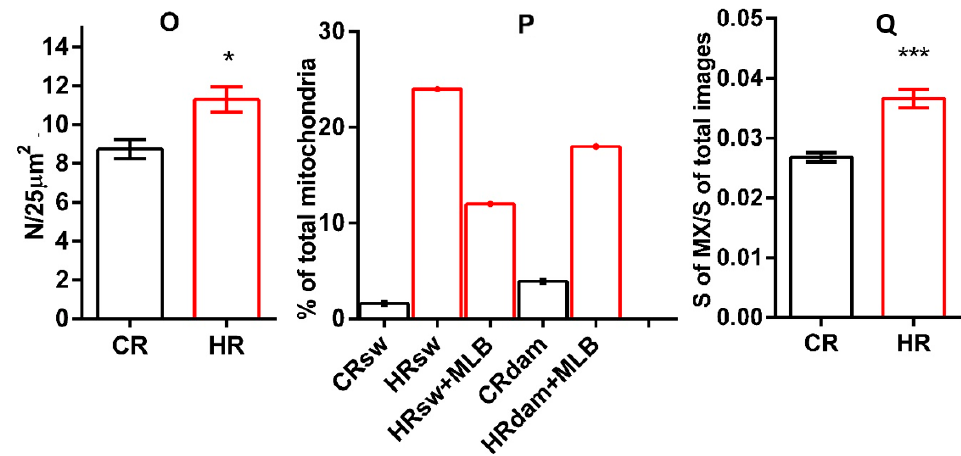
Figure 1. Typical electron micrographs of hepatic tissue in the control ( A) –( C ) and in experimental hyperthyroidism ( D) –( I ). N, nucleus. Scale bar, 2 µm. ( J) –( N ) Electron micrographs of mitochondrial morphological appearance: ( J )—well-defined, intact, organized membranes and cristae; ( K )—swollen mitochondria, slightly a decrease in the electron density of the matrix and irregular cristae; ( L )—swollen mitochondria with MLBs; ( M )—matrix vacuolization, cristae are almost not defined; ( N )—damaged mitochondria with MLBs. ( O) –( Q ) Morphometric parameters of liver mitochondria from experimental rats. ( O ) The number of mitochondria per image (25 µm 2 ). The number of examined images in each group was about 50. ( P ) Mitochondrial subpopulations occurring in the groups. The number of mitochondria analyzed in each group varied from 500 to 600. ( Q ) The ratio of the mitochondrial area to that of the total image area (25 µm 2 ). CR, control; HR, hyperthyroidism; CRsw/HRsw, swollen mitochondria; HRsw + MLBs, swollen mitochondria with MLBs; CRdam, damaged mitochondria; HRdam + MLBs, damaged mitochondria with MLBs. *—multilamellar bodies (MLBs) ( A) –( N ); *— p < 0.05 ( O) –( Q ), ***— p < 0.001 as compared with the control data ( n = 2–3 in each group).